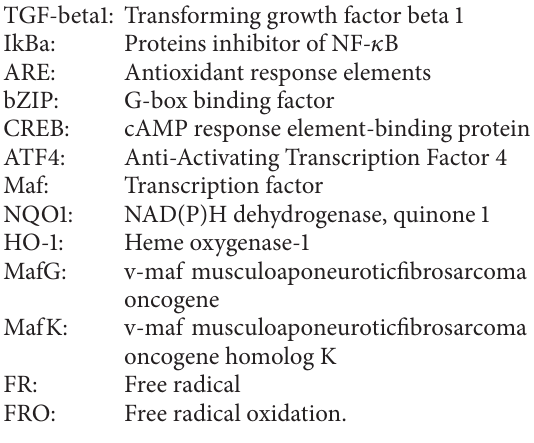
TGF-beta1: Transforming growth factor beta